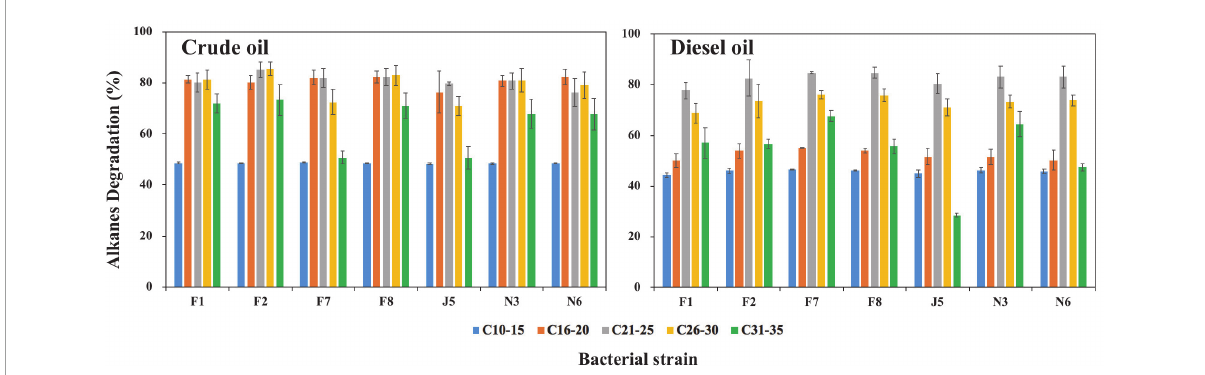
FIGURE6 Degradation of alkanes in crude oil and diesel oil by seven oil-degrading strains after 20-day incubation in MMC medium. Error bars represent standard deviations of means ( n = 3). F1, F2, F7, F8, J5, N3, and N6 refer to strain Acinetobacter venetianus F1, Alcanivorax marinus F2, Kangiella aquimarina F7, Limimaricola variabilis F8, Marinobacter nauticus J5, Flavobacterium sediminis N3, and Paracoccus sediminilitoris N6,